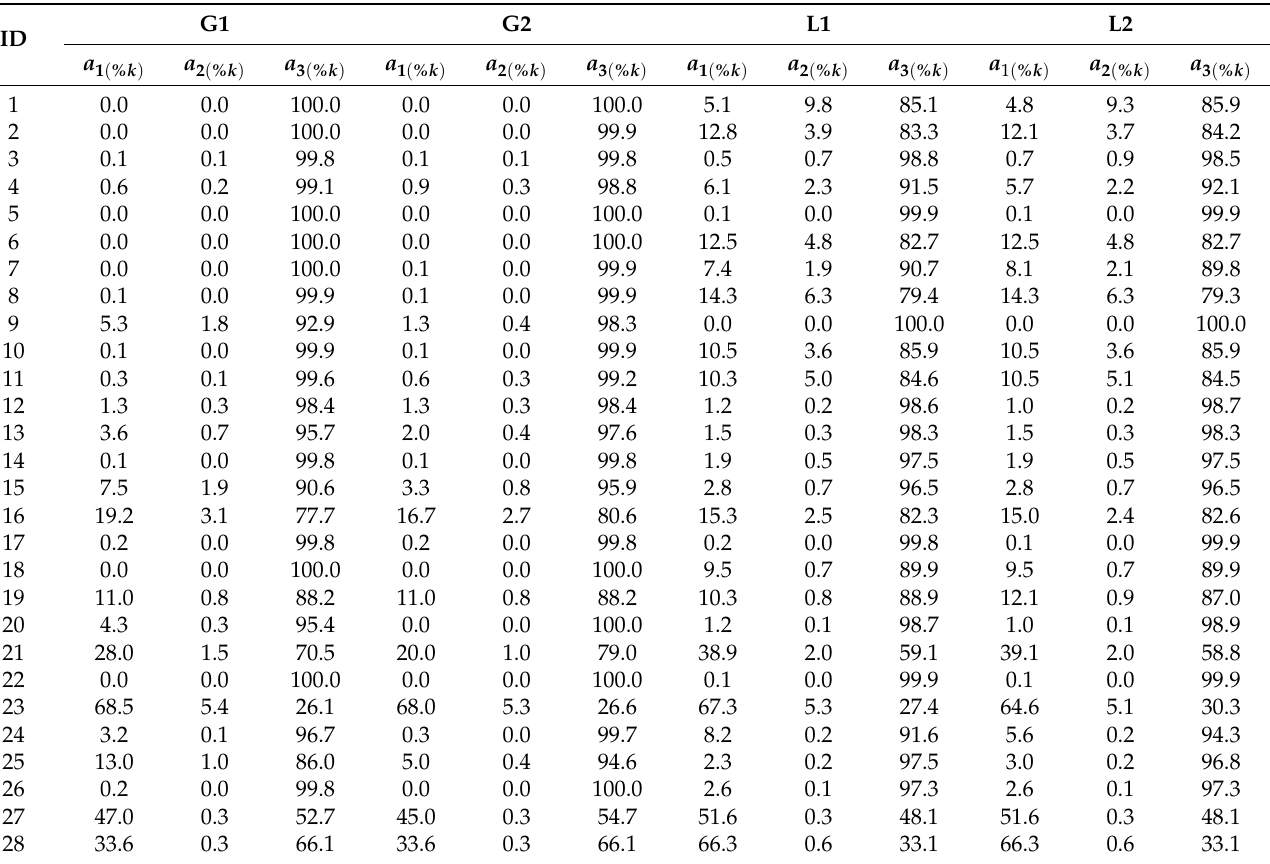
Table 8. Percentual contributions from a 1 . a 2 , and a 3 to k index considering each